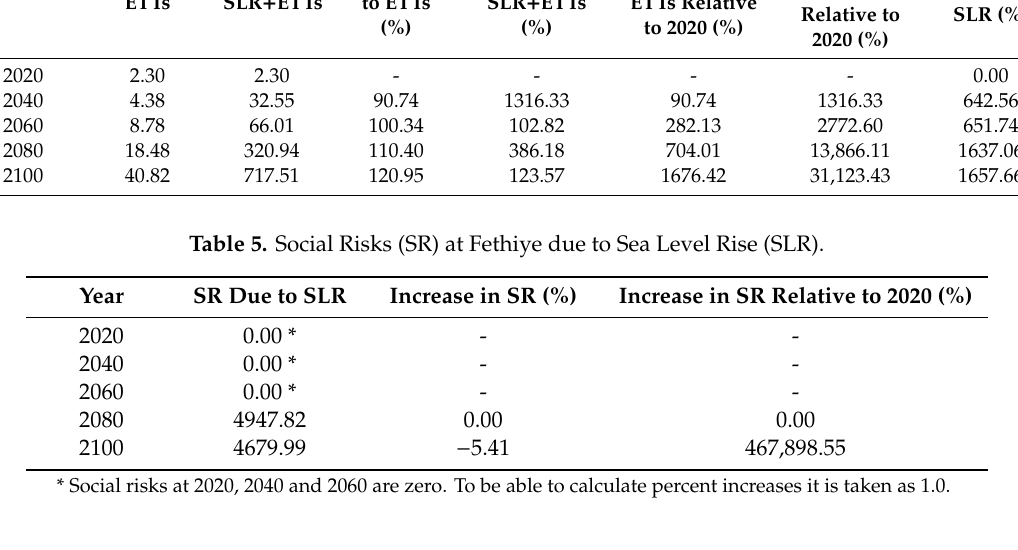
Table 6. Comparison of Social Risks (SR) at Fethiye due to Earthquake Triggered Tsunami (ETTs) and Sea Level Rise